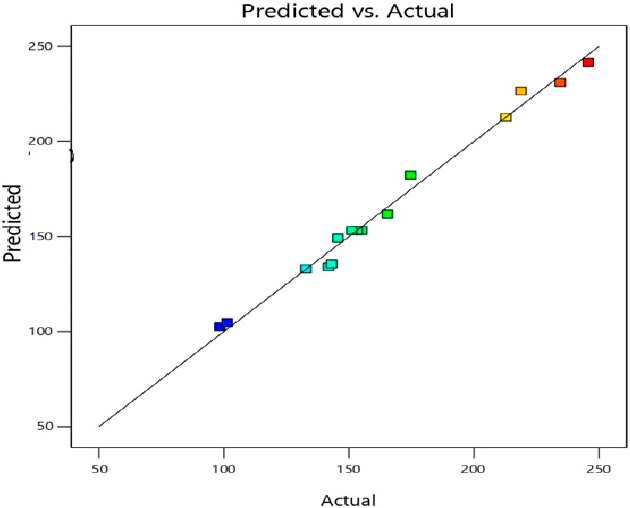
Figure 1. Predicted versus actual values of the vesicle size of different experimental runs of ICA- phytosomes.